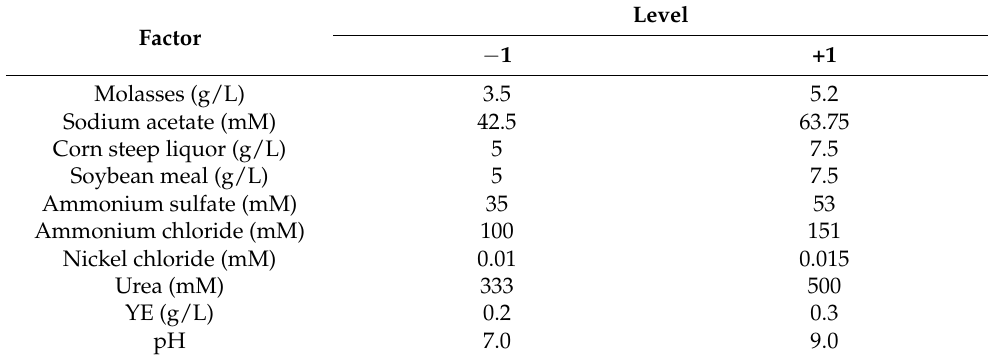
Table 2. Factors and levels of the PB test.